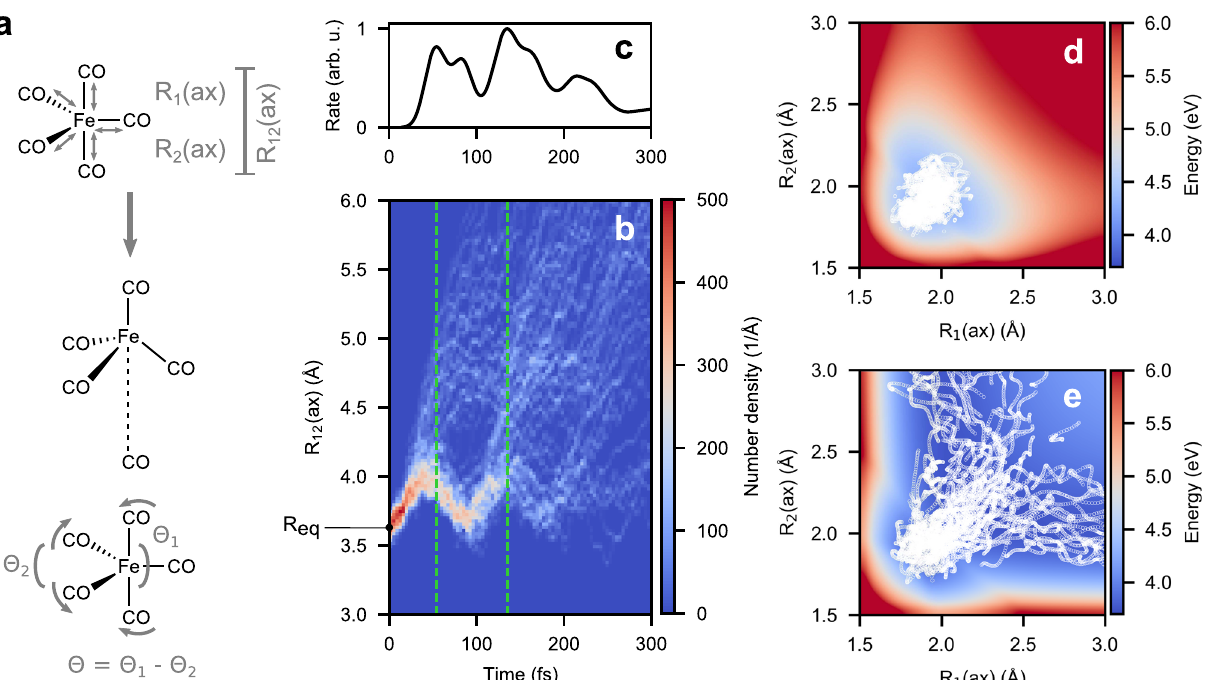
Fig. 2 Release of axial CO from photoexcited Fe(CO) 5 synchronous with the symmetric stretch mode in axial Fe – C bonds. a Schematic diagram for de fi nition and relevance of the R 12 (ax) coordinate in axial CO dissociation, and the angular difference ( Θ = Θ 1 − Θ 2 ). b Plot of distribution of R 12 (ax) as a function of time for the 94 trajectories yielding axial CO release. c Rate of axial CO release as a function of time (obtained from the dissociation times τ dissoc ) showing clearly visible periodic bursts ~90 fs apart. The rate curve is obtained by applying a smoothing Gaussian convolution of the distribution of τ dissoc with a full-width half-maximum of 10 fs. d , e Two-dimensional cuts in the potential energy surfaces (PES) of S 6 (top) and S 3 (bottom) states obtained by time-dependent density functional theory (TDDFT) scans along the axial Fe – C R 1 (ax) vs R 2 (ax) distances. The white scatter overlaid on the PES shows segments populating these states in the trajectories in ( b